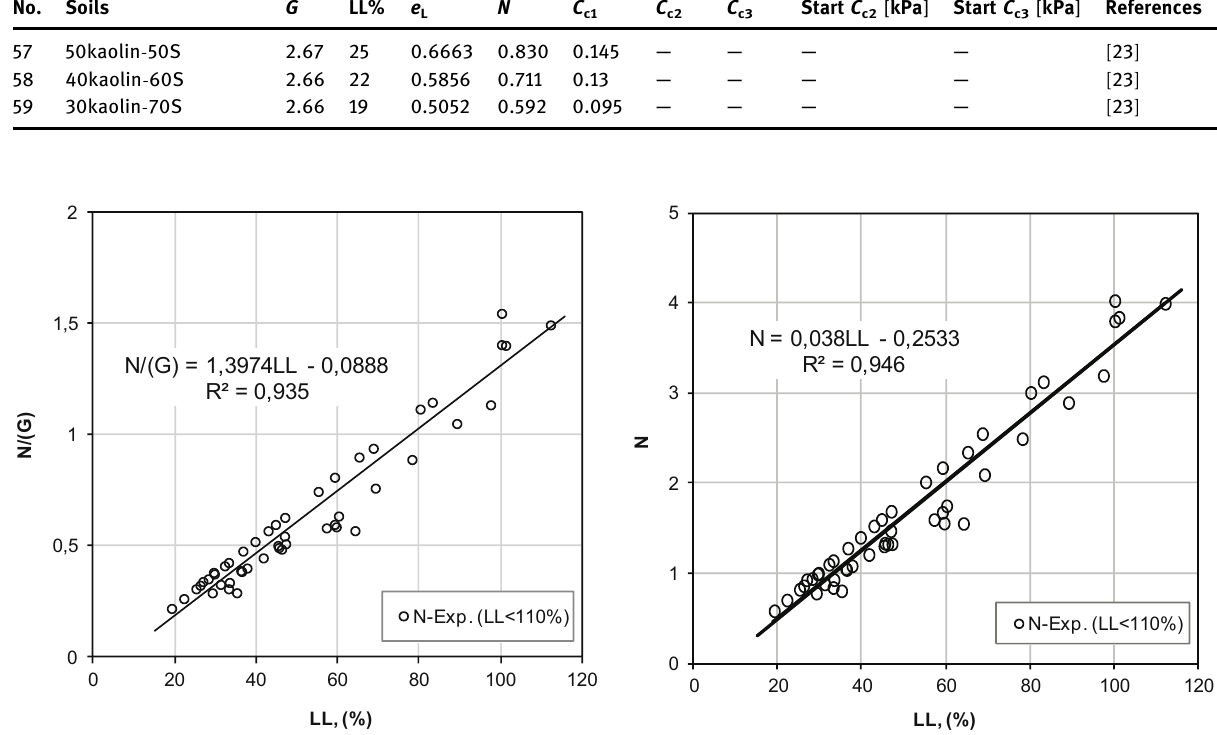
Figure 5: Best - fi t relationship of N vs LL < 110%.